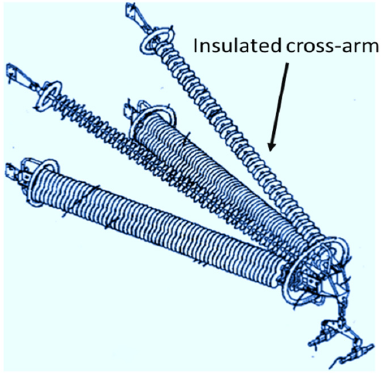
Figure 10. Insulated cross-patent under PCT [53].